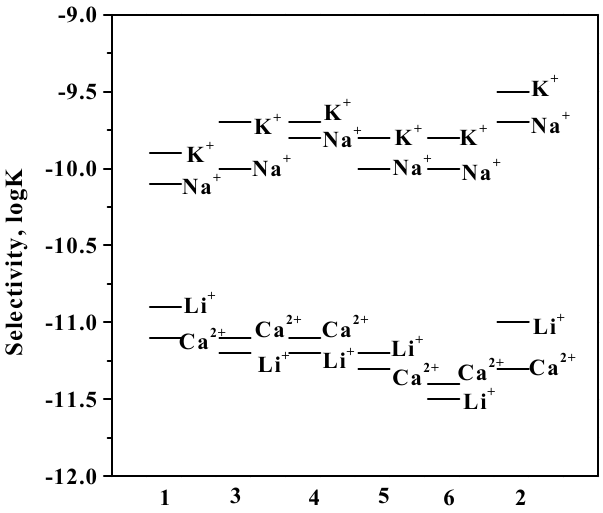
Figure 5 . The selectivity coefficients expressed as logK of ISEs based on 1-6 (Numbers 1-6 correspond to the entry numbers in Table 1) for H + over other cations using the mixed solution method at 10 -2 M calcium ion and 10 -1 M of lithium, sodium, potassium ions as interfering